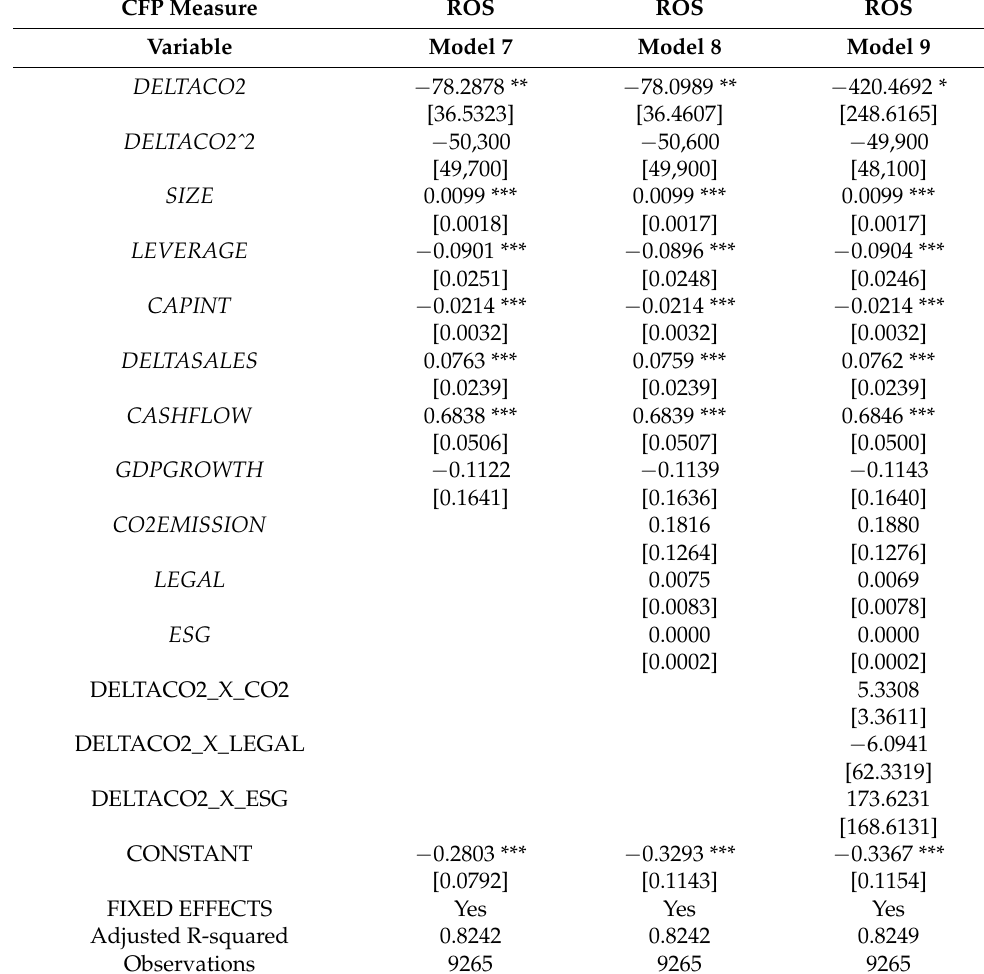
Table 4. Regression analysis on